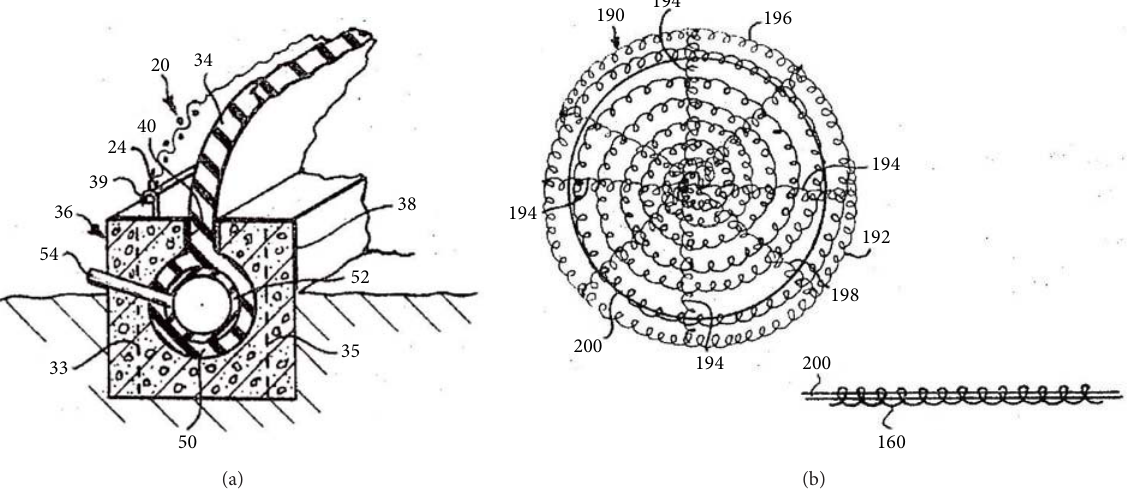
Figure 6: Bini’s fixation of the membrane in the groove (a) and the special perpendicular reinforcement (b) [11].